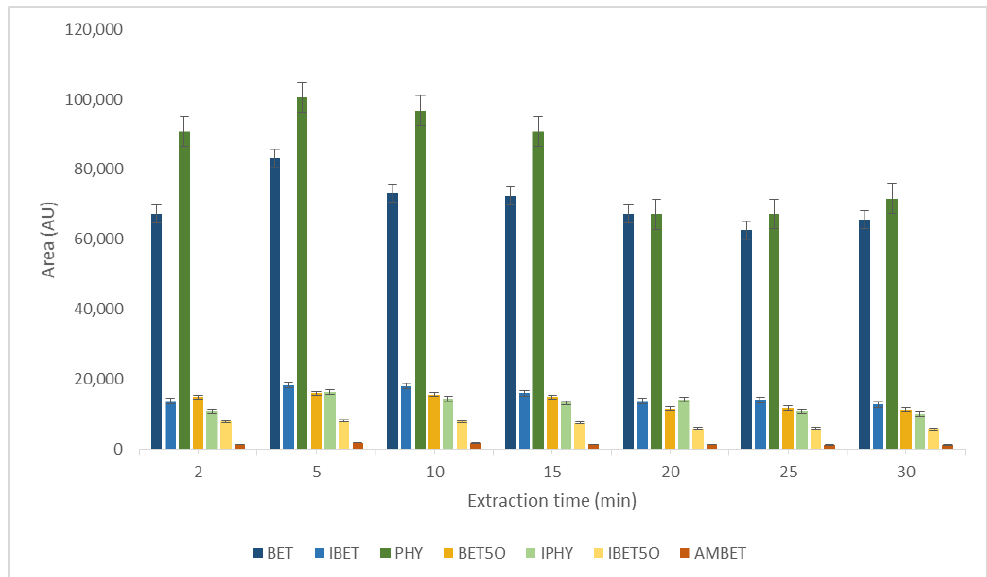
Figure 4. Effect of extraction time on the amount of betacyanins extracted.